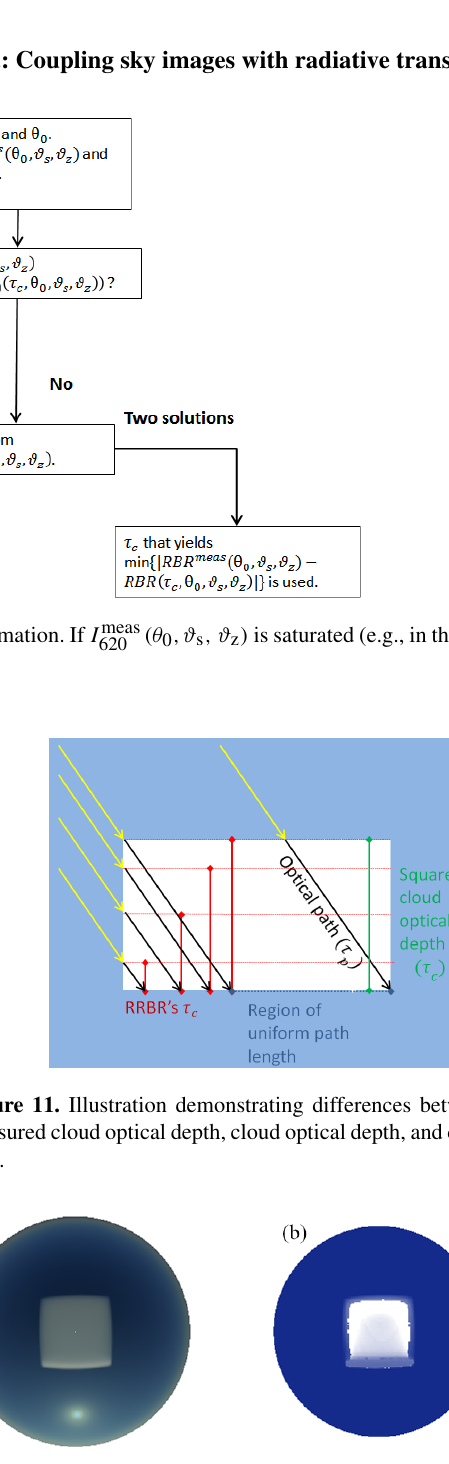
Figure 12. (a) SHDOM simulated sky image of a 1km × 1km square cloud with cloud geometric thickness of 0.2km at a θ 0 = 60 ◦ and τ c = 10 (b) and RRBR τ c retrieval. The RRBR τ c is 8, 0.2km from the cloud edge facing the sun.